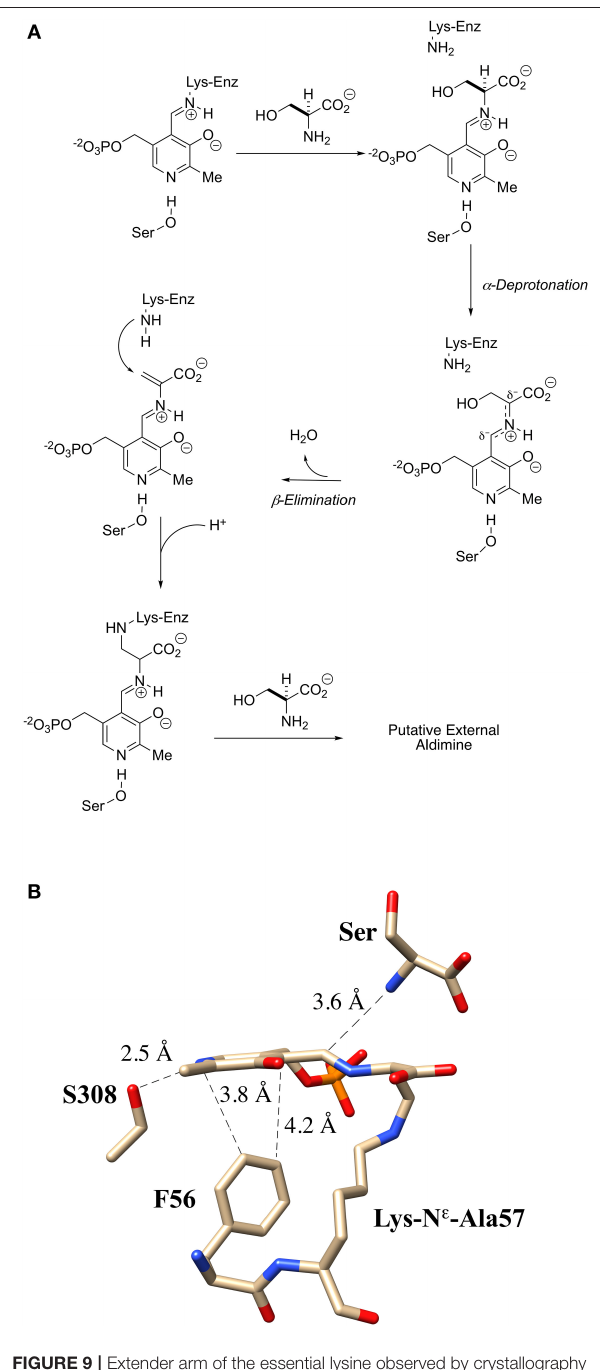
FIGURE 9 | Extender arm of the essential lysine observed by crystallography of S. pombe serine racemase. (A) Potential mechanism for formation of the extender arm. (B) Crystal structure of the internal aldimine with the “extended”-lysine residue